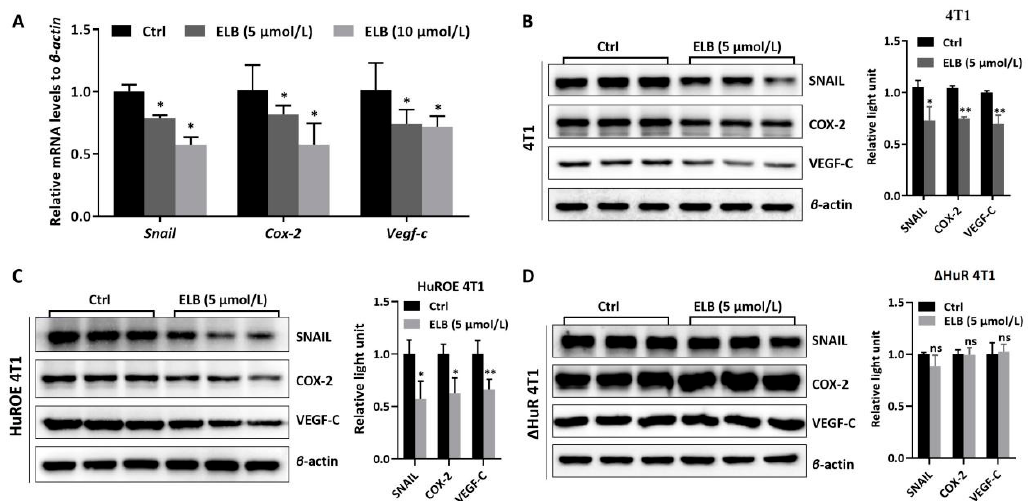
Figure 4. Impact of eltrombopag on the expression of Snail , Cox-2, and Vegf-c in 4T1, HuROE 4T1, or Δ HuR 4T1 cells. ( A ) The mRNA levels of Snail , Cox-2, and Vegf-c in 4T1 cells were tested by qRT-PCR. ( B ) The protein expression of Snail , Cox-2, and Vegf-c was detected in 4T1 cells via Western blot, photographs, and quantification. ( C ) The protein expression of Snail , Cox-2 , and Vegf-c was detected in HuROE 4T1 cells via Western blot, photographs, and quantification. ( D ) The protein expression of Snail , Cox-2, and Vegf-c was detected in Δ HuR 4T1 cells via Western blot, photographs, and quantification. Mean ± SD. n = 3. * p < 0.05 ( t -test), ** p < 0.01 ( t -test), ns means no significant difference.